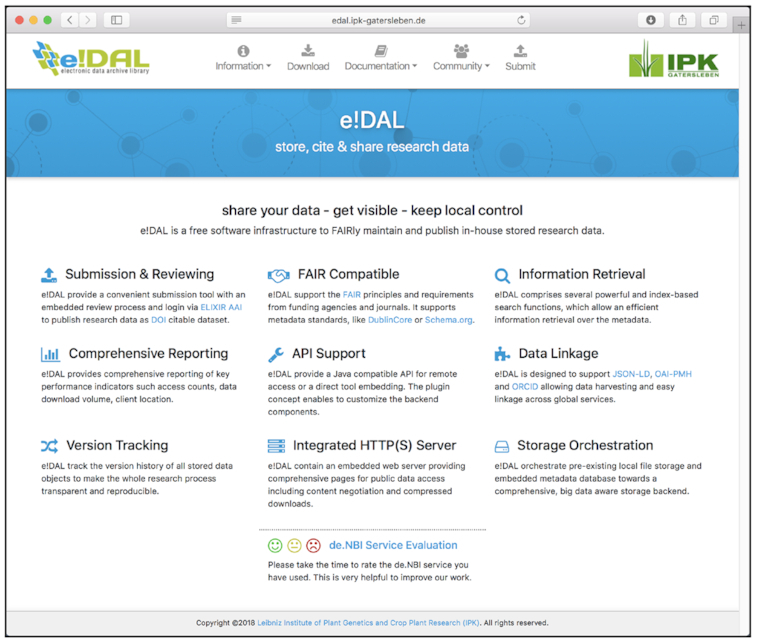
Screenshot of the e!DAL website, which provides a detailed description on how to use the e!DAL infrastructure software, as well as comprehensive examples for users and developers. Furthermore, some video tutorials and presentation recordings are available to lower the initial barriers to digging into the e!DAL infrastructure.